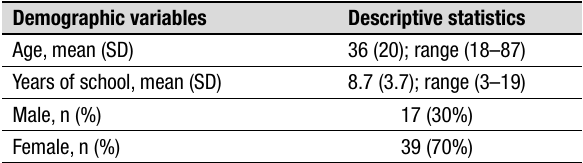
Table 1. Demographic characteristics of the sample